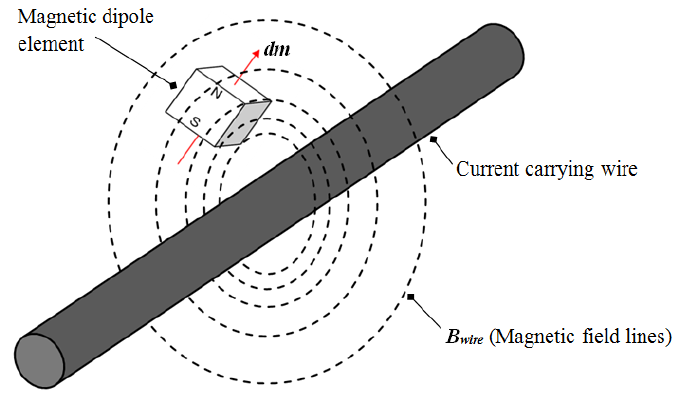
Figure 3. Magnetic dipole element placed in the magnetic field of a current carrying wire.